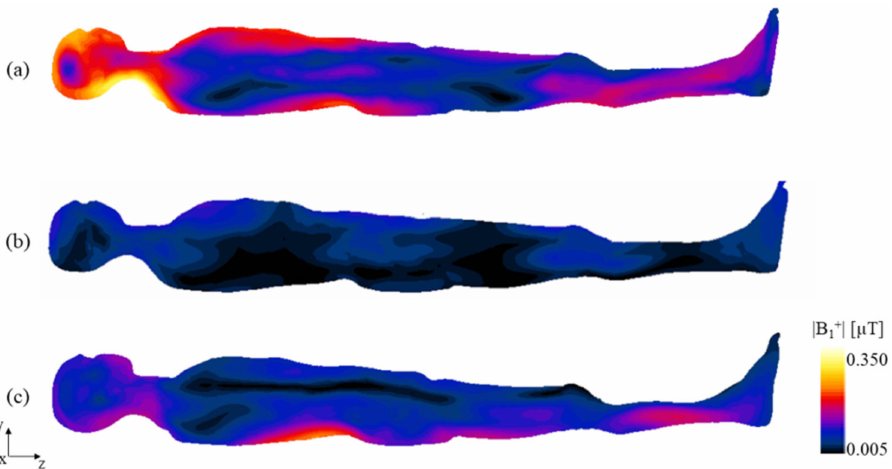
Figure 7. The computed |B 1+ |-field inside the human model in sagittal view, for ( a ) the path antenna, ( b ) birdcage coil and ( c ) the array of triple-line microstrips.